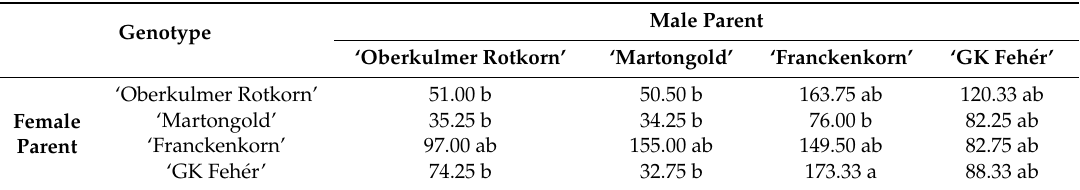
Table 1. Mean of embryo-like structures (ELS) production anther culture of a full diallel spelt wheat population. Values with the same capital letters are not significantly di ff erent ( p > 0.05).